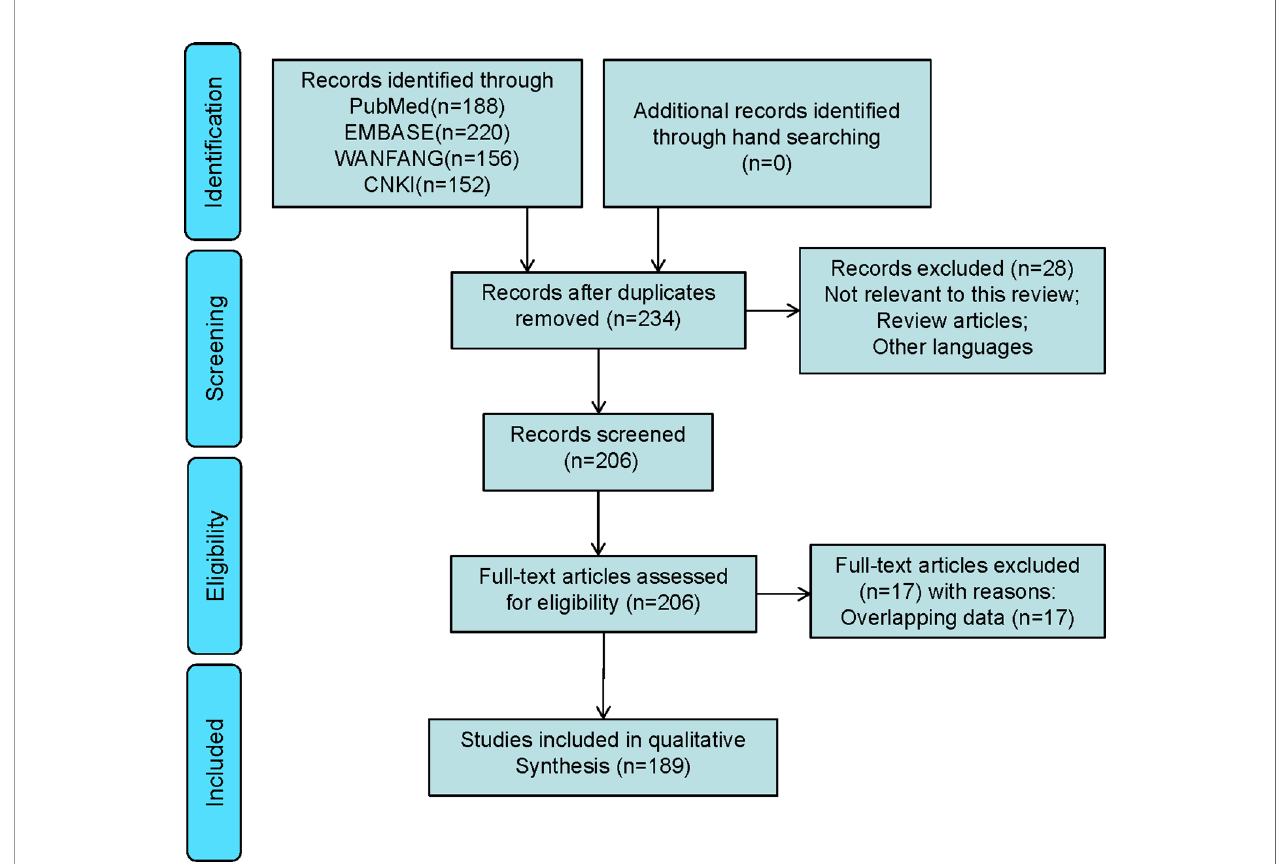
FIGURE 1 | Selection of studies for inclusion in the systematic review of LCA.